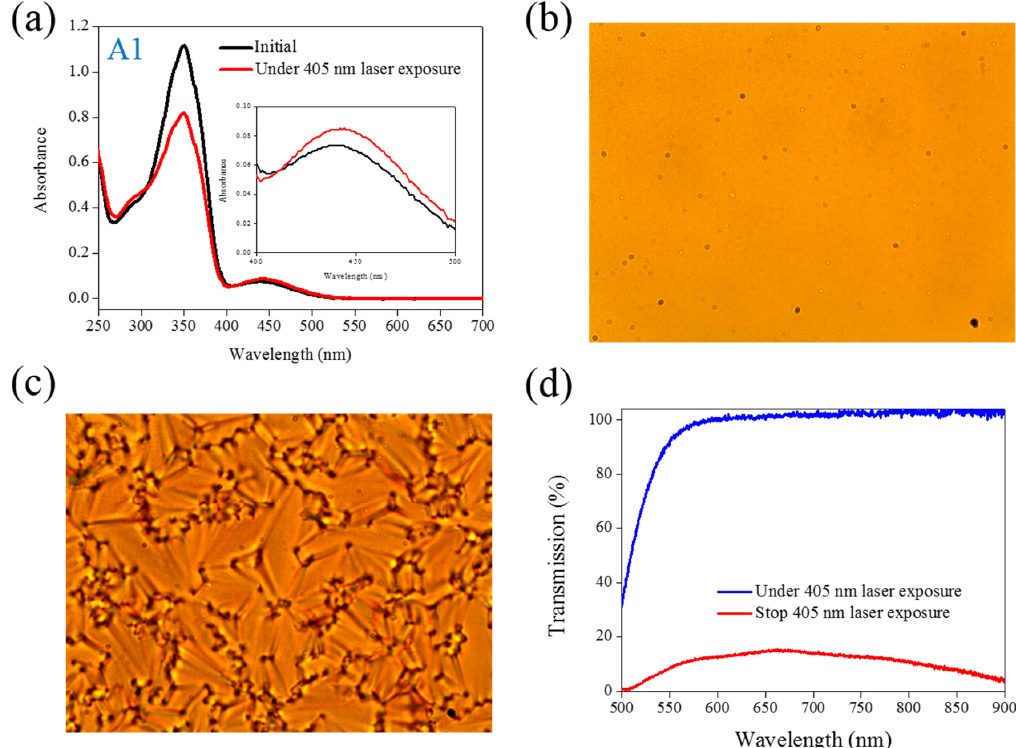
Figure 1. ( a ) Absorption spectral response of A1 of M 5 101 in the tetrahydrofuran (THF) solution before and under 405-nm laser irradiation; ( b , c ) Typical POM images (picture area: 270 μ m × 320 μ m) of A1-doped CLC (15 wt% A1, 20 wt% ZLI811, and 65 wt% MDA3461) under ( b ) and stop ( c ) 405-nm laser exposure; ( d ) The transmission spectra of A1-doped CLC under different conditions of laser